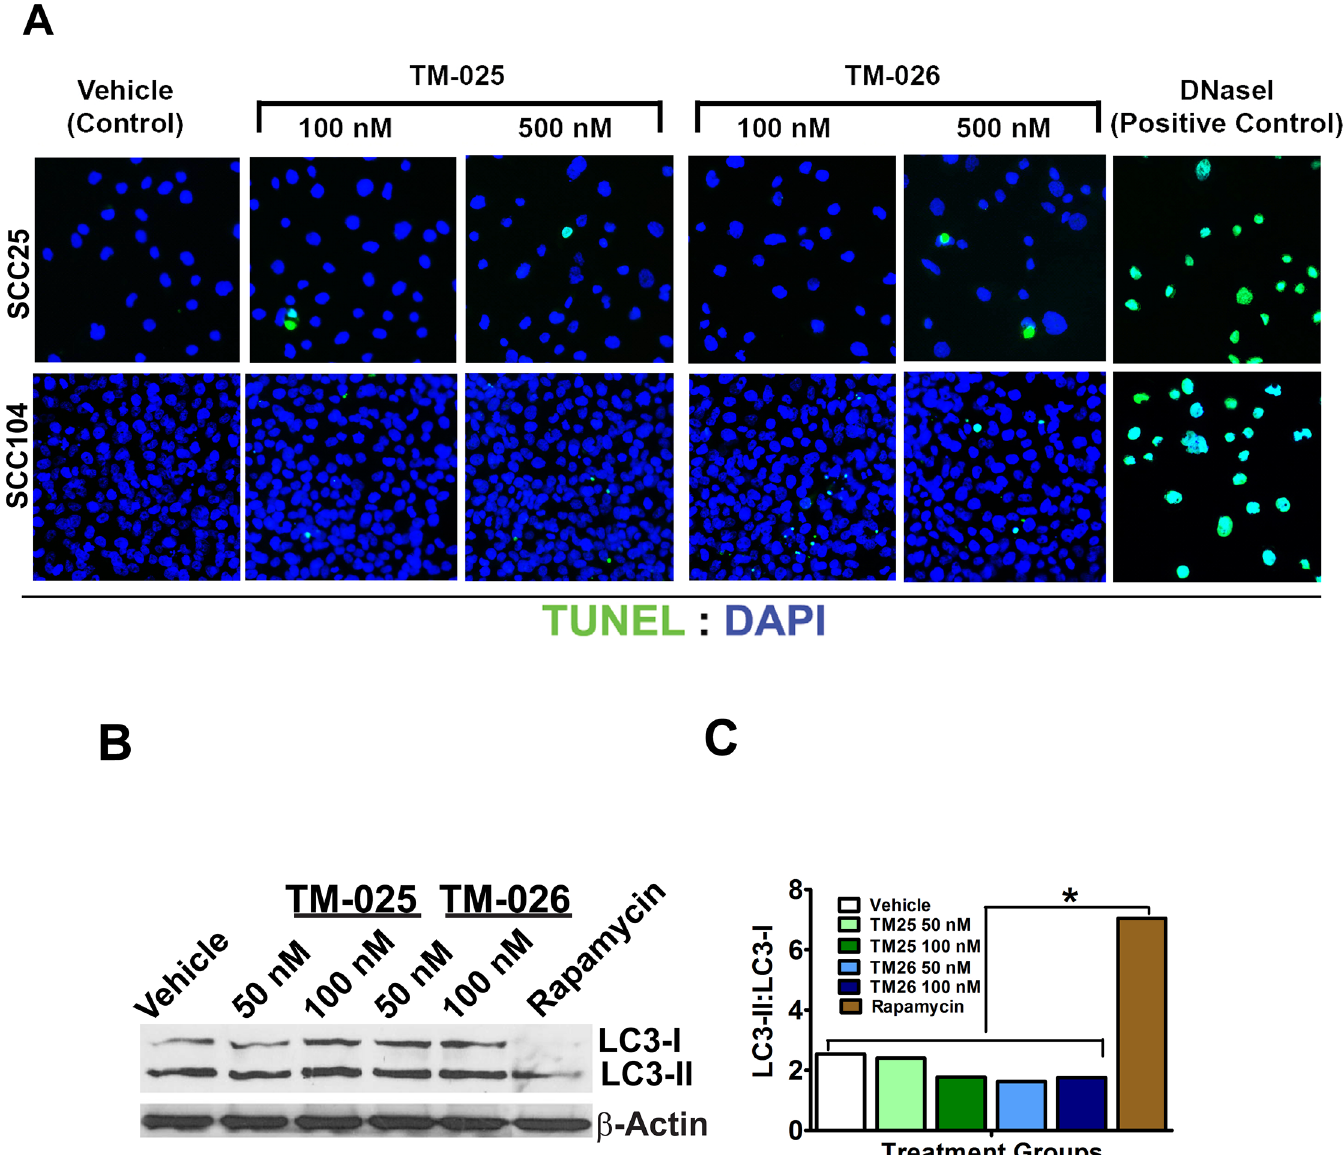
Fig 4. PCT analogs did not cause apoptosis or autophagy. (A): TUNEL assay: 24-h treatment with increasing concentrations (100 and 500 nM) of TM- 025 and TM-026 did not show a significant (p < 0.05) number of TUNEL + apoptotic cells (green fluorescence) marked with arrow-heads in SCC25 and SCC104 cells. DNase I (100 ul; 10 U/ml; positive control) treated cells were used as a positive control. (B-C): Autophagy was estimated as a measure of ratio of cellular LC3-II to LC3-I. (B) Western blot depicting levels of LC3-I and LC3-II in PCT analog-treated cells. (C) The ratio of LC3-II:LC3-I did not show a significant (P < 0.05) induction (represented by * ) of autophagy in the PCT analog-treated cells, in comparison to the positive control (cells treated with 100 μ l of 50 ng/ml rapamycin). All sample groups were found to be identical to the vehicle-treated group at the same level of significance (i.e., P <